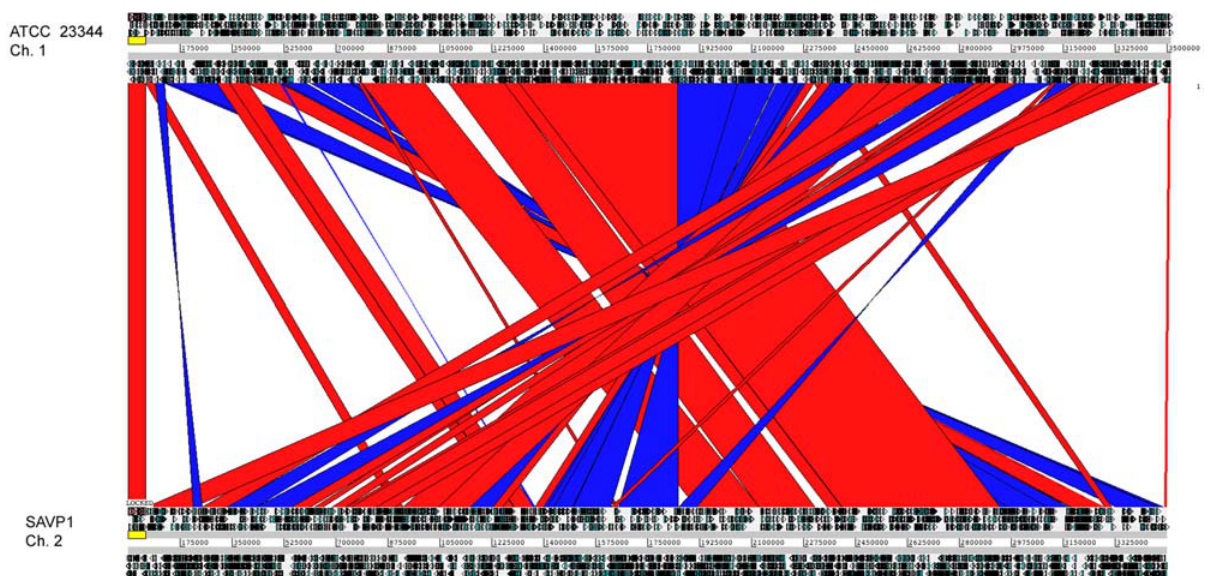
Figure 2. Comparison of the large chromosomes of B.mallei ATCC 23344 (top) and B.mallei SAVP1 (bottom) using ACT and the whole genome alignment MUMmer. Regions of similarity, rearrangements, and deletions are readily apparent between these two strains. The red and blue bands represent the forward and reverse matches, respectively. The ATCC 23344 large chromosome (CP000010) is 3.51 Mb and the SAVP1 large chromosome (CP000526) is 3.49 Mb.